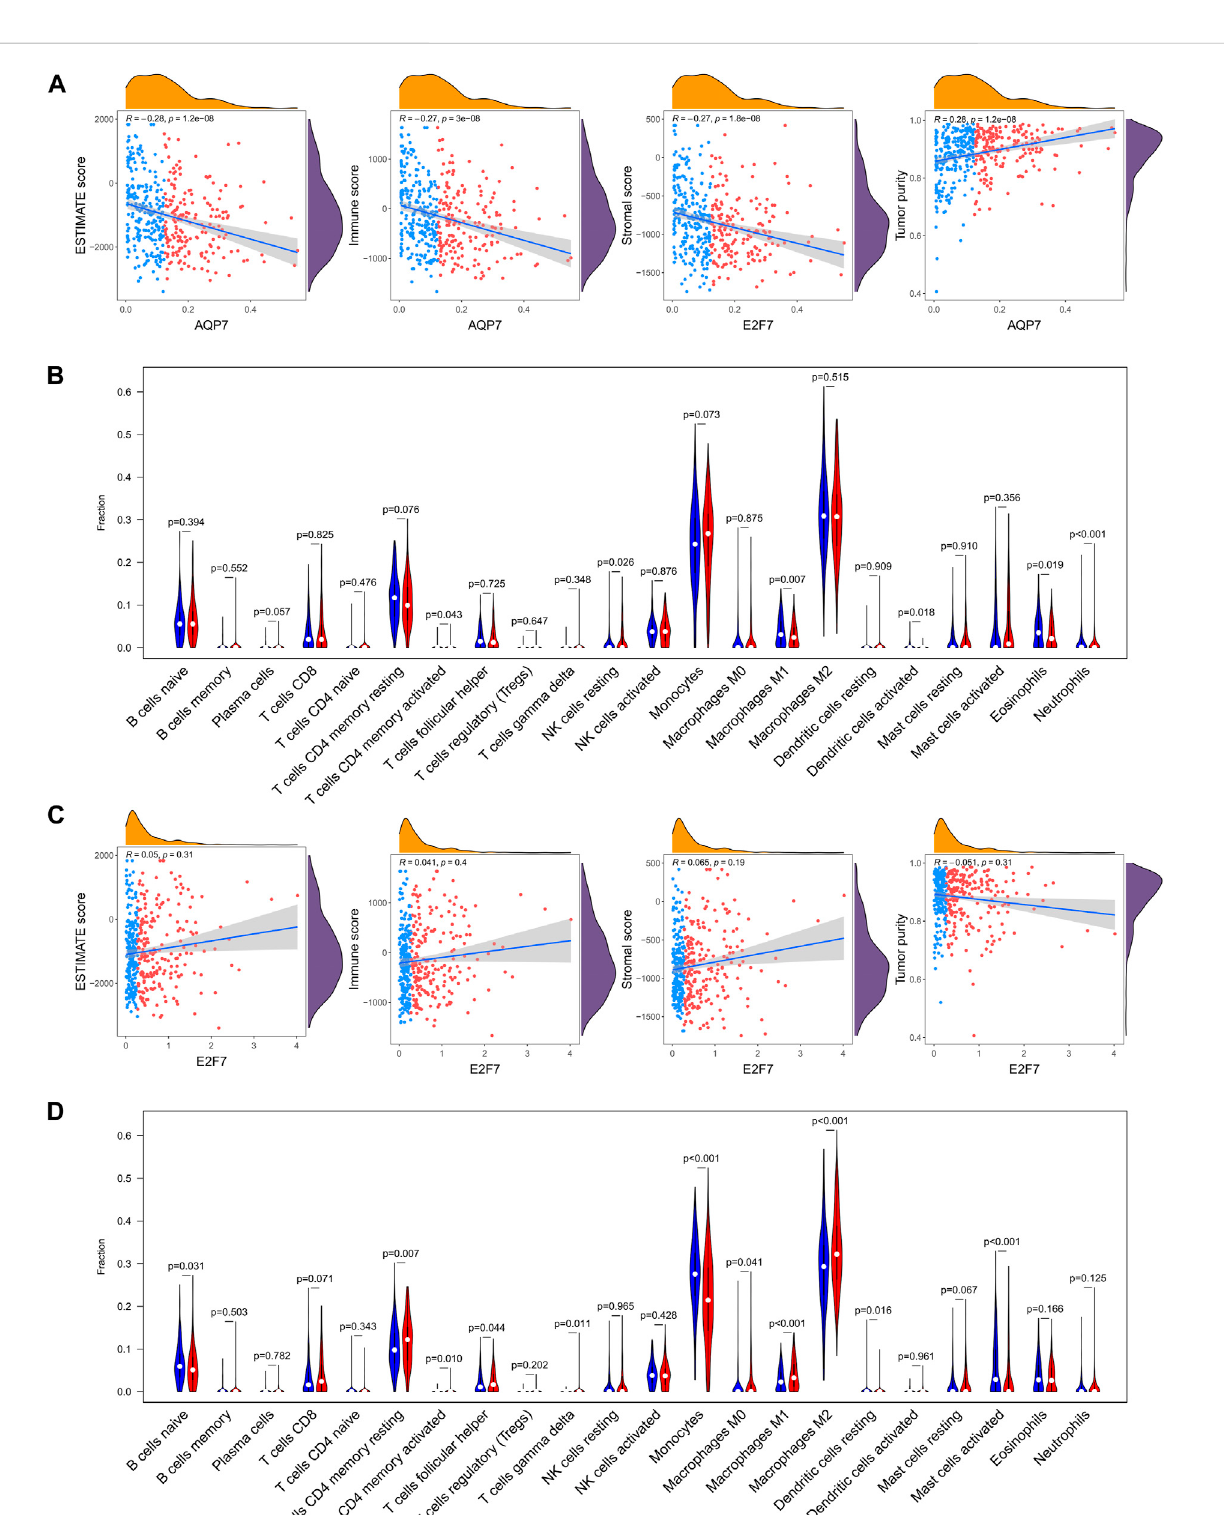
FIGURE 10 The relations between the selected gene and tumor immune features. (A) The abundance of 22 immune cells in the high-expression and low- expression of AQP7. (B) Correlation of the expression of AQP7 with immune scores, stromal scores, ESTIMATE scores, and tumor purity. (C) The abundanceof22immunecellsinthehigh-expressionandlow-expressionofE2F7. (D) CorrelationoftheexpressionofE2F7withimmunescores,stromal scores, ESTIMATE scores, and tumor purity. * p < 0.05, ** p < 0.01, *** p < 0.001, and ns No signi fi